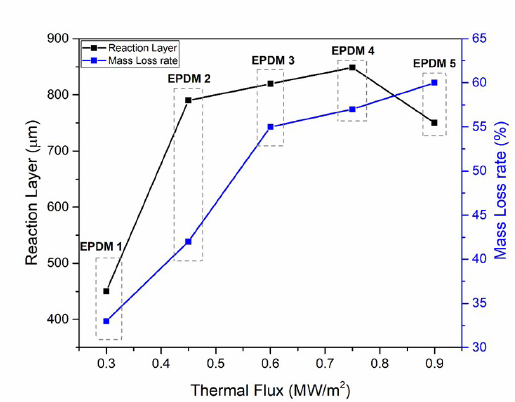
Figure 8. Reaction layer and mass loss